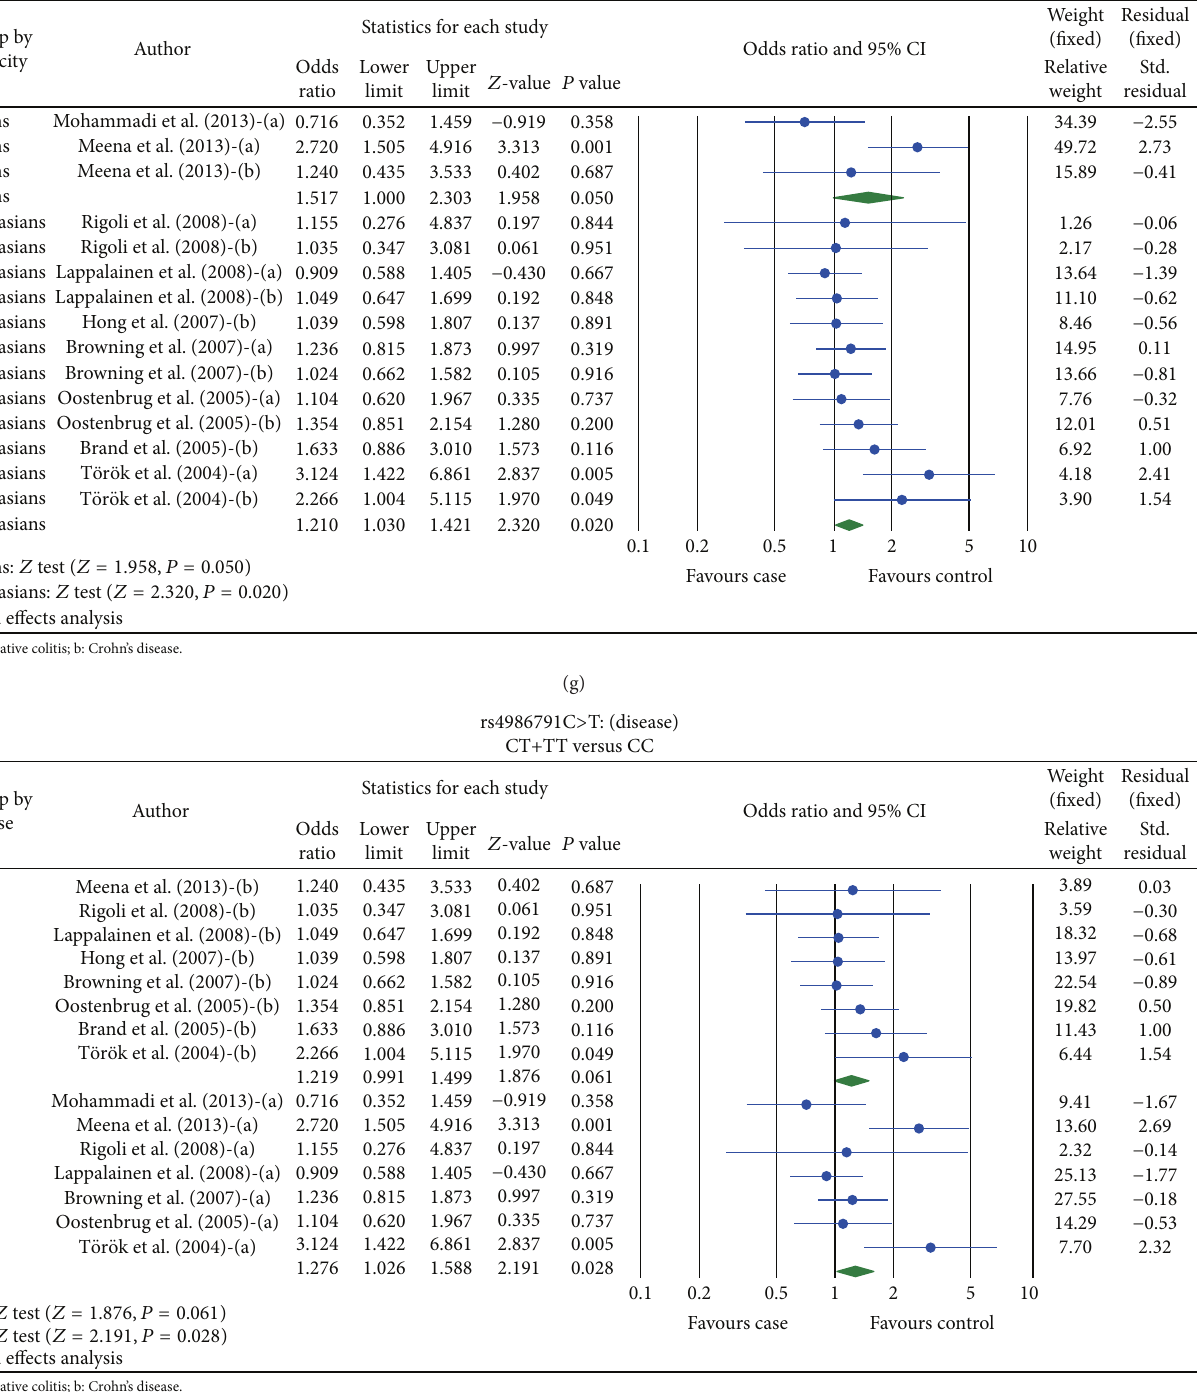
Figure 3: Subgroup analysis of the differences in allele and genotype frequencies of TLR4 rs4986790A > G and rs4986791C > T polymorphism between case and control groups. (a) Ethnicity analysis of the differences in allele frequencies of TLR4 rs4986790A > G; (b) disease analysis of the differences in allele frequencies of TLR4 rs4986790A > G; (c) ethnicity analysis of the differences in genotype frequencies of TLR4 rs4986790A > G; (d) disease analysis of the differences in genotype frequencies of TLR4 rs4986790A > G; (e) ethnicity analysis of the differences in allele frequencies of TLR4 rs4986791C > T; (f) disease analysis of the differences in allele frequencies of TLR4 rs4986791C > T; (g) ethnicity analysis of the differences in genotype frequencies of TLR4 rs4986791C > T; (h) disease analysis of the differences in genotype frequencies of TLR4 rs4986791C >